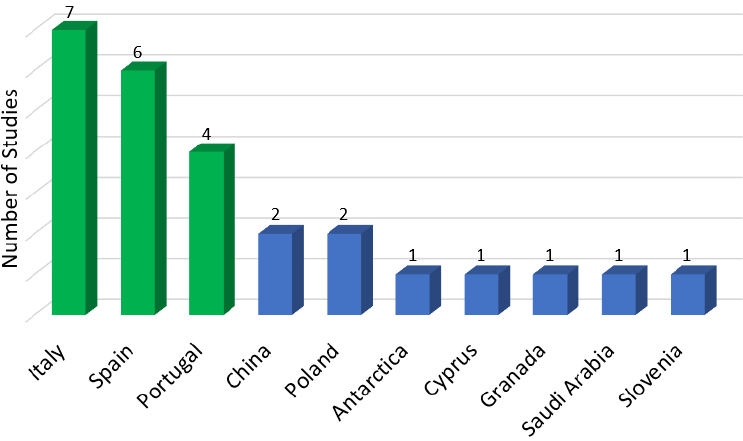
Figure 7. Location of 26 HBIM case studies published between 2018–2022.